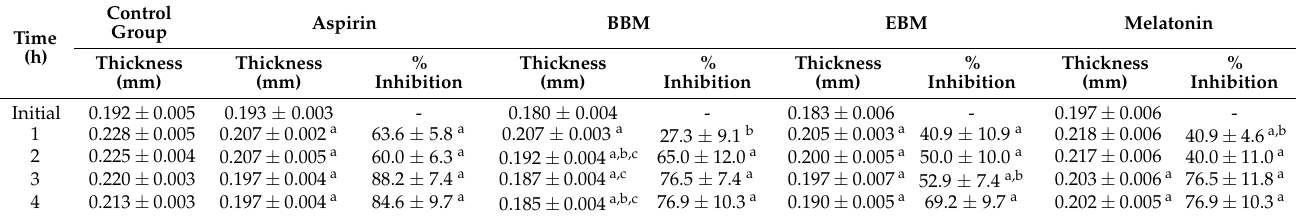
Table 1. Ear thickness of mice (mm) and % inhibition of croton oil-induced ear